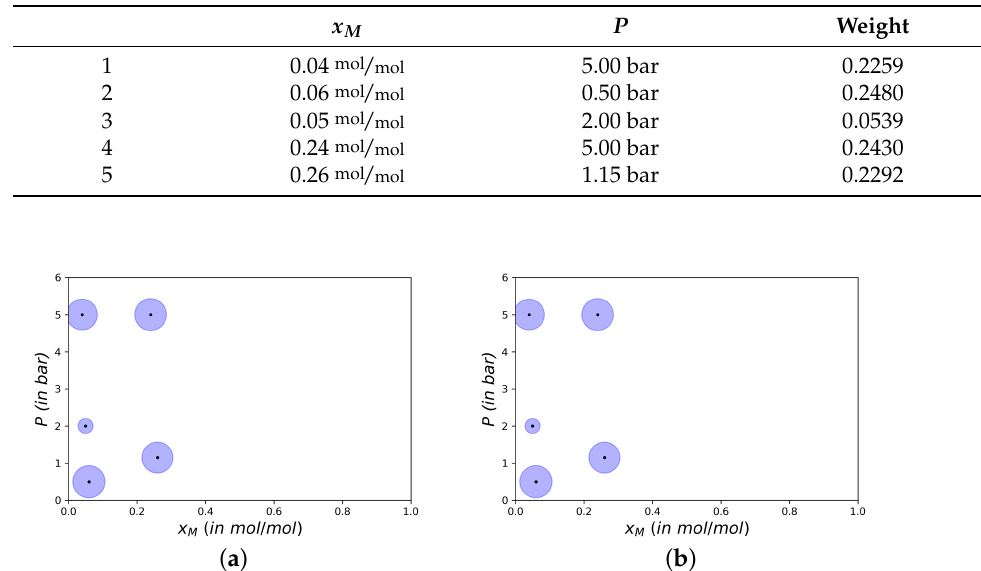
Figure 4. Optimal designs in the two-dimensional design space for the flash with a methanol–water input feed. ( a ) The design ξ VDM computed with the VDM. ( b ) The design ξ YBT computed with the YBT algorithm.